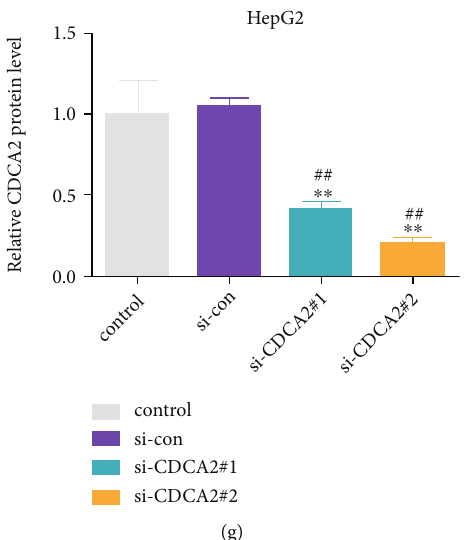
Figure 1: Knockdown or overexpression of cell division cycle associated 2 (CDCA2) in hepatocellular carcinoma (HCC) cells. (a) The expression of CDCA2 was higher in HCC cells than that in L-02 cells, p < 0 : 01 versus L-02. (b) – (d) CDCA2 expression was obviously elevated at mRNA and protein levels with pcDNA3.1-CDCA2 stimulation. ** p < 0 : 01 versus control and ## p < 0 : 01 versus vector. (e) – (g) si-CDCA2#1 or si-CDCA2#2 treatment obviously suppressed CDCA2 expression than the control and si-con. ** p < 0 : 01 versus control and ## p < 0 : 01 versus